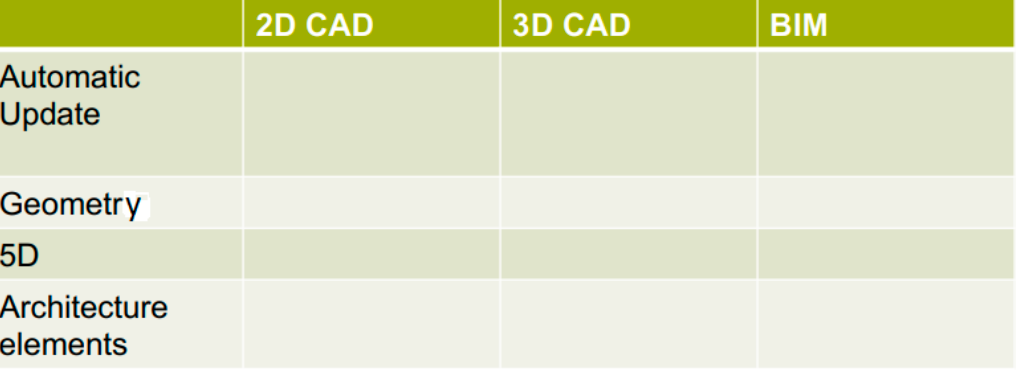
Figure 2. Example of a theoretical question.